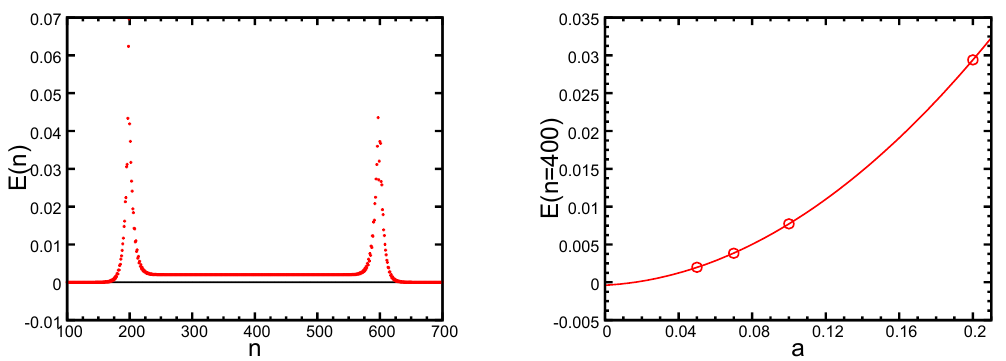
Figure 7 . (Left): site dependence of the local energy, E ( n ) with a = 0 . 05 , N = 801 , m lat = 0 . 00 , θ = 0 in the presence of the probe charges with q p = 2 . 0 at n = 200 and n = 600 . (Right): the data in the continuum limit of the local energy at n = 400